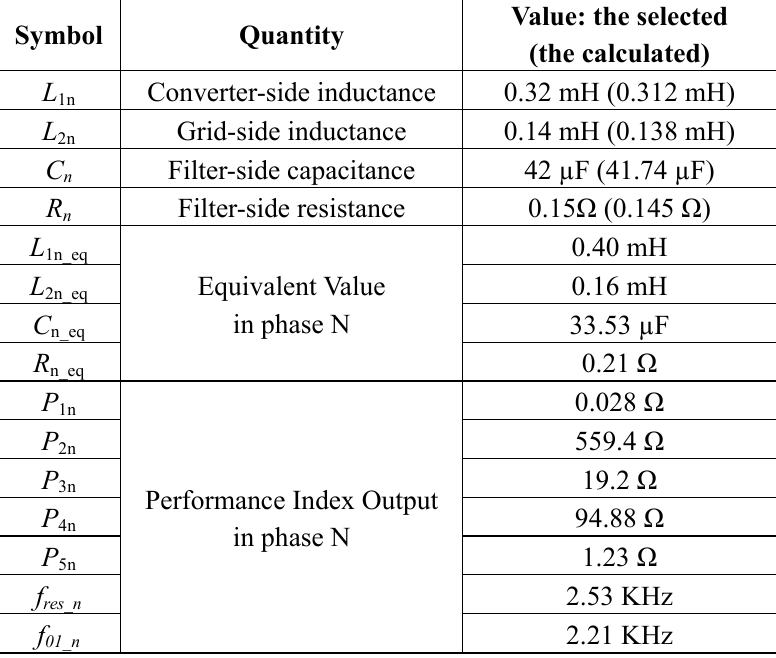
Table 4. Parameters selected and its performance index in phase N.